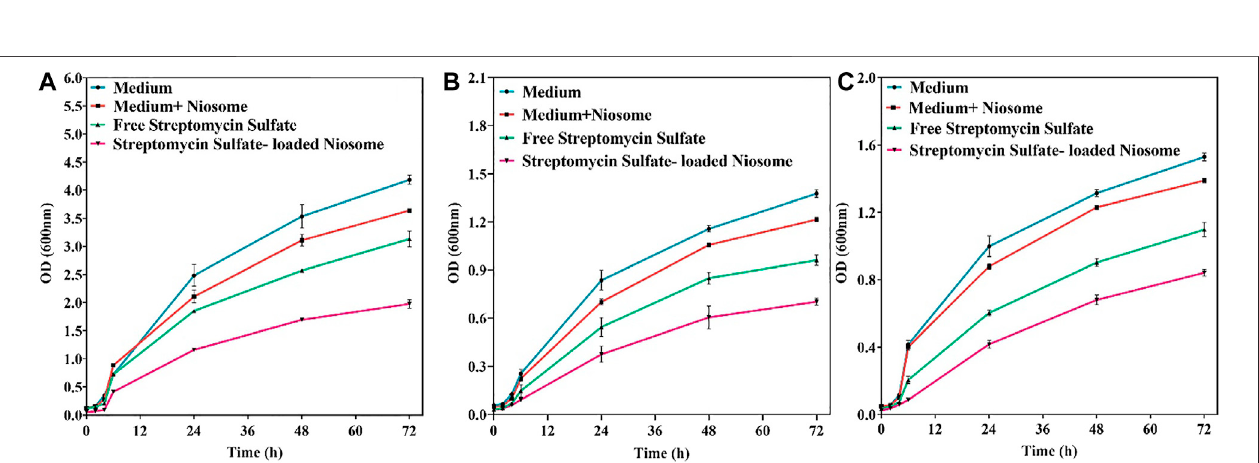
FIGURE 6 | Antibacterial activity offreestreptomycin and encapsulated streptomycin against pathogenic bacteria: S. aureus (A) , E. coli (B) , and P. aeruginosa (C) measured by optical density as a function of time (72 h). Each point corresponds to a mean ± SD with three replicates per condition.